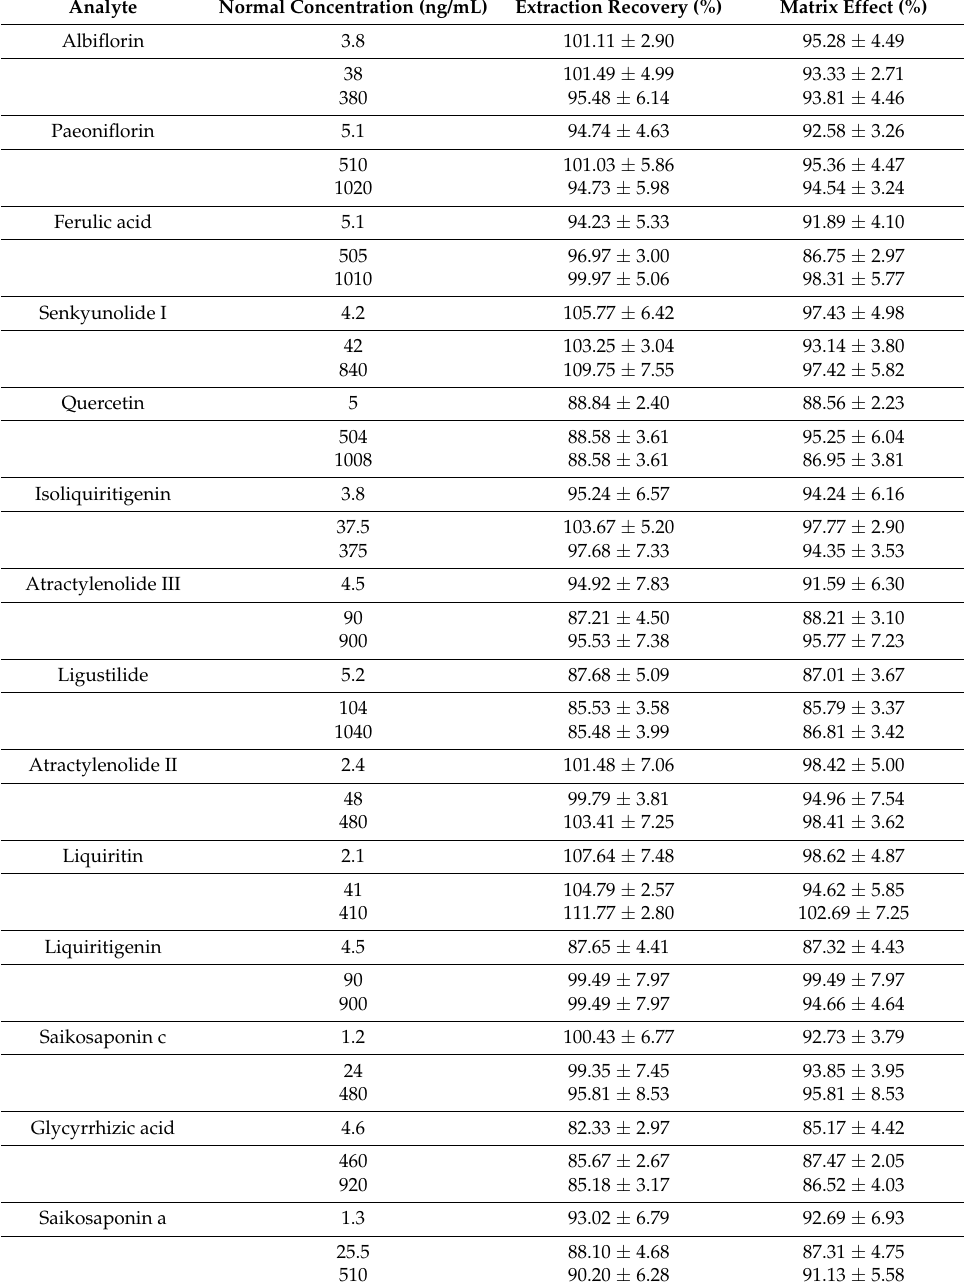
Table 3. Extraction recovery and matrix effect at low, intermediate and high concentration levels (mean ± SD, n =